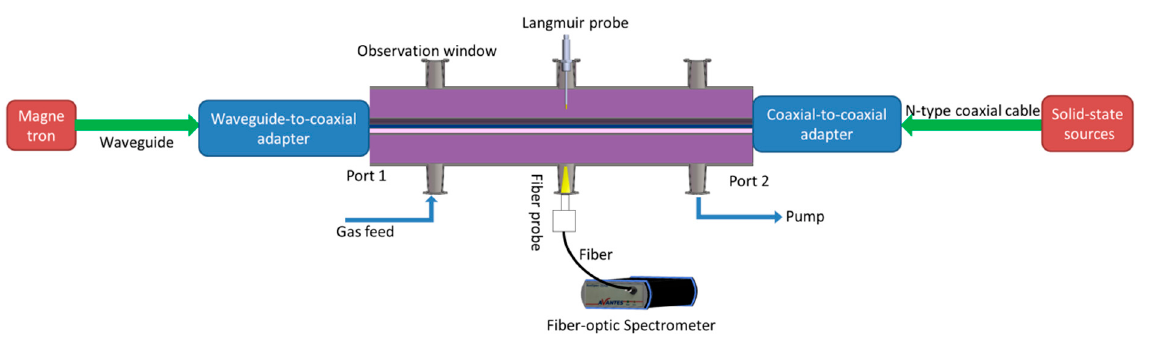
Figure 1. Schematic of the coaxial line plasma driven by the dual microwave sources. The plasma reactor is a coaxial line, whose outer diameter is 150 mm and the inner diameter is 8 mm. A quartz glass tube surrounds the inner conductor. Between the outer conductor and the quartz glass tube, there is a vacuum region in which the plasma is excited. There are two microwave ports at the two ends of the coaxial transmission line.